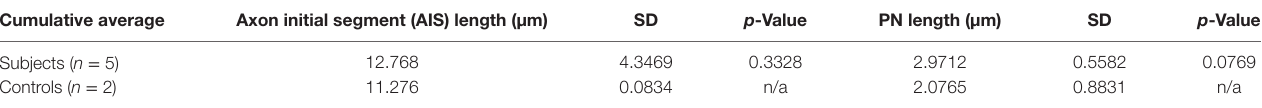
Table 3 | Statistical